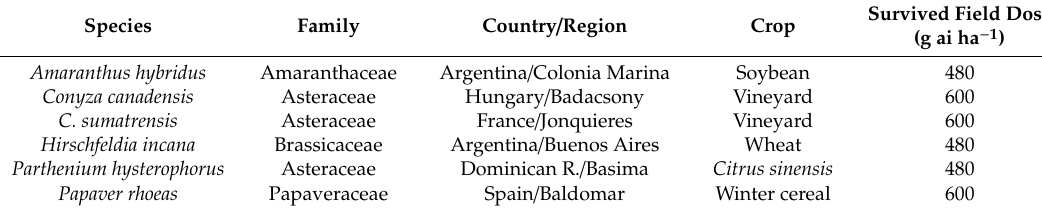
Table 1. Most important characteristics of the dicotyledonous species resistant (R) to 2,4-D studied. Species Family Country / Region